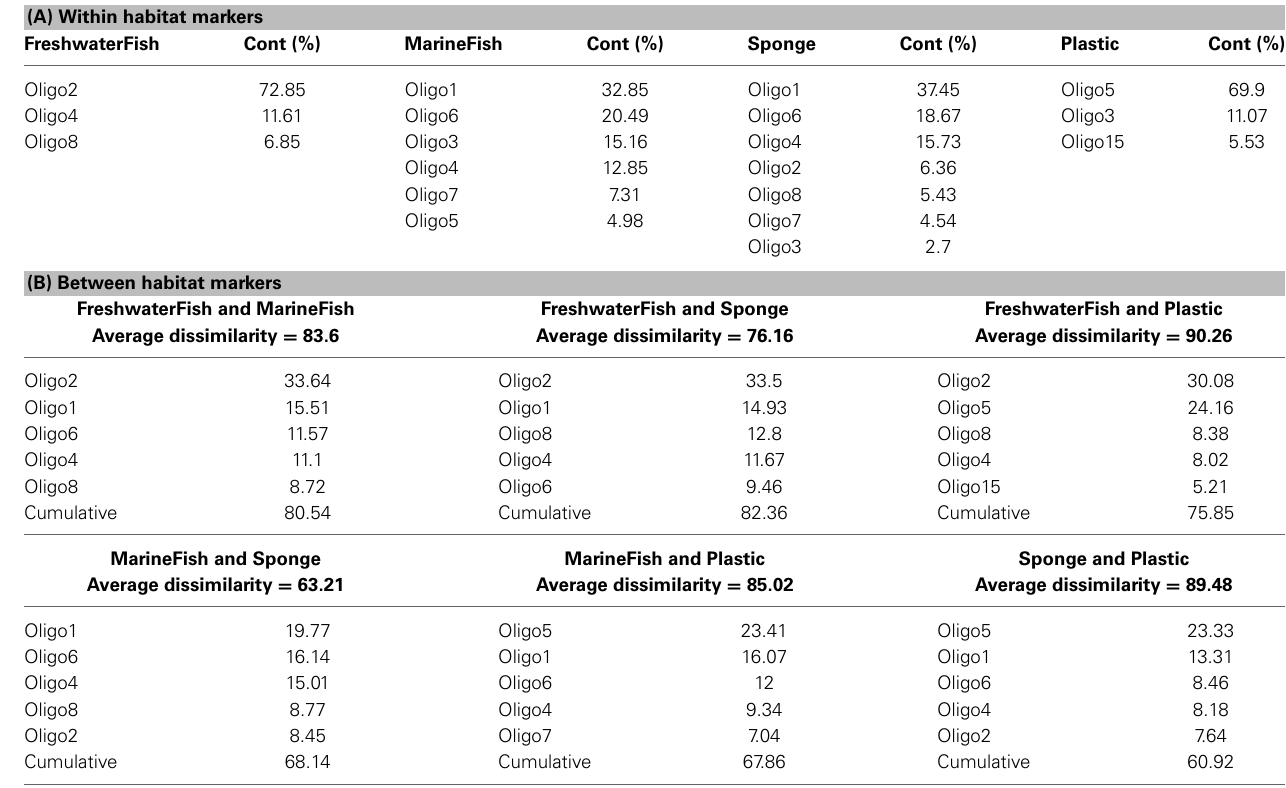
type. Pairwise ANOSIM permutation tests reveal all host habitats can be significantly differentiated except MarineFish and Sponge communities (Table S1).